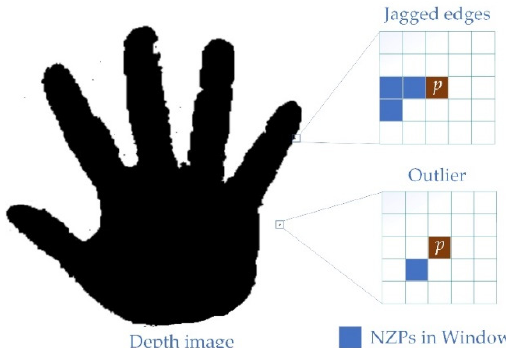
Figure 5. The locations of the points determined to be eliminated. For window areas with a small number of non-zero points, most of them are outliers or located on the jagged edge. This figure shows this case with k = 5. Other sizes of windows are similar.